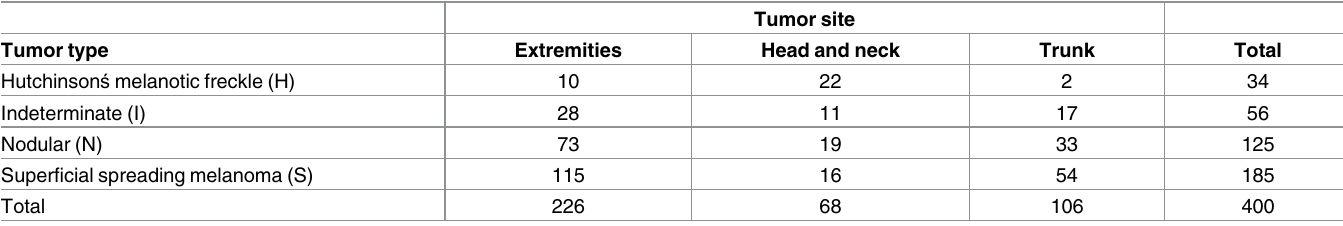
Table 3. Data from the malignant melanoma example for testing independence between tumor type and tumor